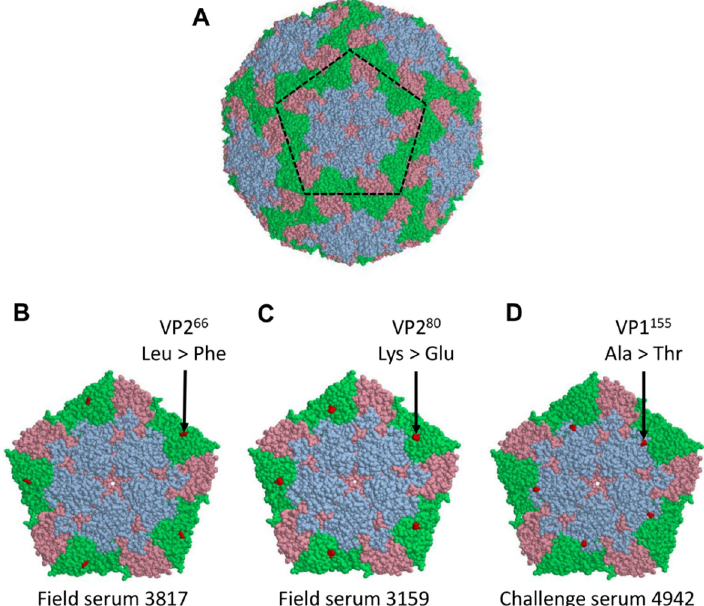
Figure 4. Surface-exposed non-synonymous mutations. The mutations that became fixed at consen- sus level in the viral populations passaged in the presence of sera from the Field and Challenge groups (but not identified within the starting inoculum or viruses passaged in the presence of